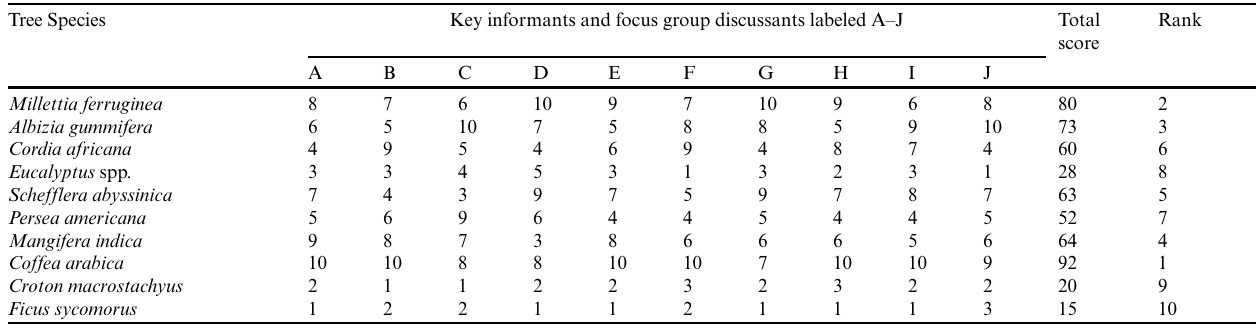
Table 3 . Results of preference ranking of trees based on multiple use-values exercised by key informants (KI) and focus group discussants (FGD). Scores in the table indicate ranks given to multipurpose trees based on their use-values (highest number (10) was given for the tree species which informants thought most-preferred in its use-values, and the lowest number (1) was given for its least-preference). The highest total scores were the most-preferred tree species by the farmers. Letters A-J represent KI and FGD. Tree Species Key informants and focus group discussants labeled A–J